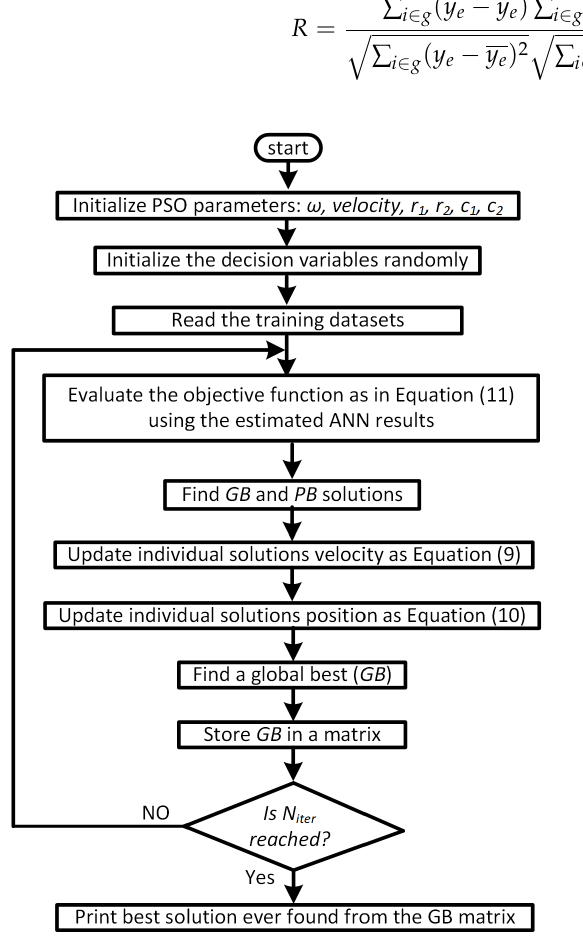
Figure 5. Optimal ANN design for the SSSC